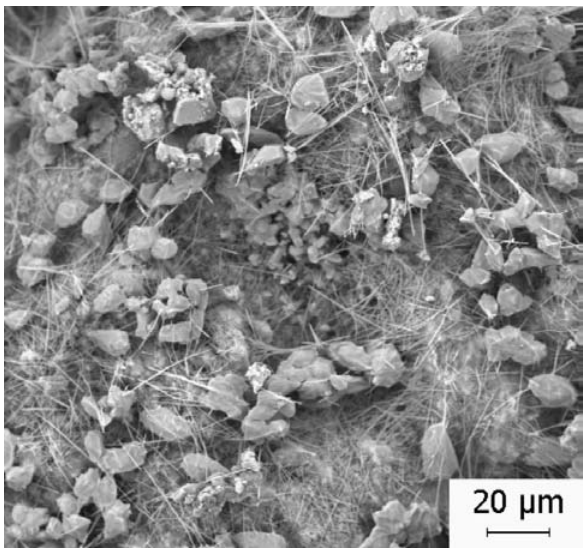
Figure 12. SEM micrograph of crystals growing on the surface of aggregates in the (J) samples (CPI-S-32 cement/5% bottom ash/sand) after 28 days of aging.